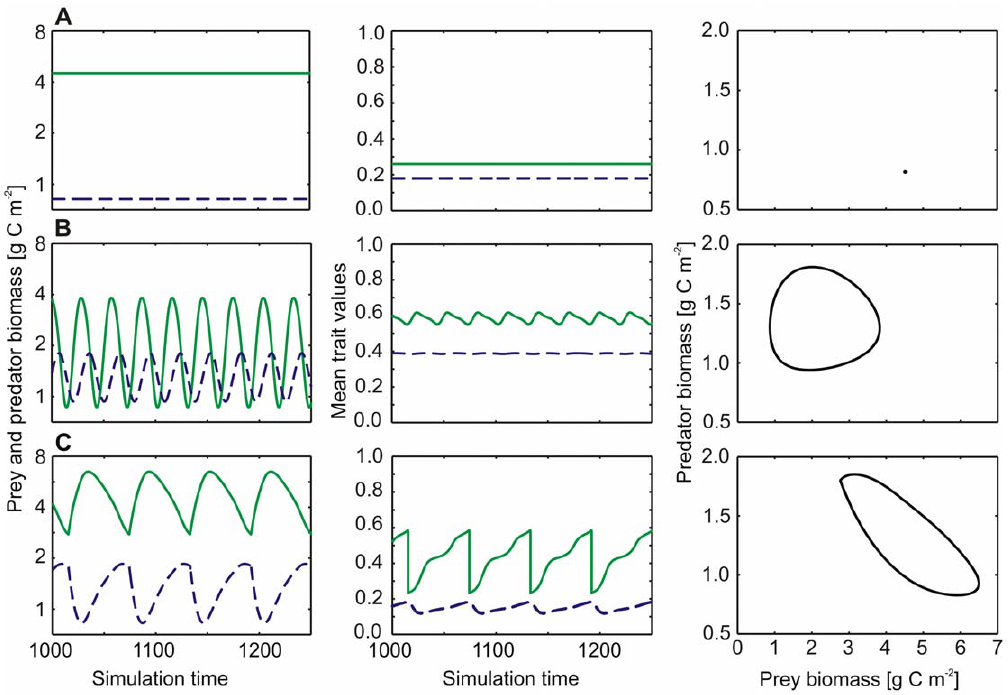
Figure 6. Different types of dynamic patterns obtained at different parametrization. Left: simulated prey (green solid line) and predator biomass (blue dashed line), middle: the respective trait values (green solid line for Q and blue dashed line for v ), and right: phase portraits of predator and prey biomass after a spin-up of 2000 days. Model run with ( A ) a ~ 2 : 1 , ( B ) b ~ 5 , ( C ) c ~ 2 : 3 . Other constants as in Table 1.